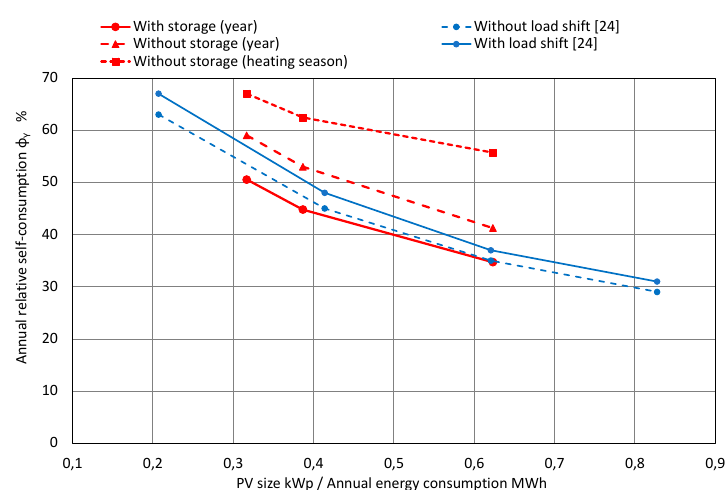
Figure 18. Comparison of relative self-consumption to average self-consumption, with and without load shifting and for different PV system sizes [12].